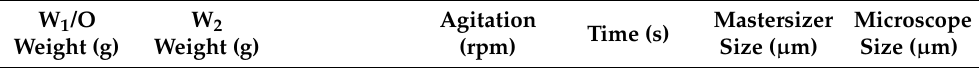
Table A3. Preparation of W 1 /O/W 2